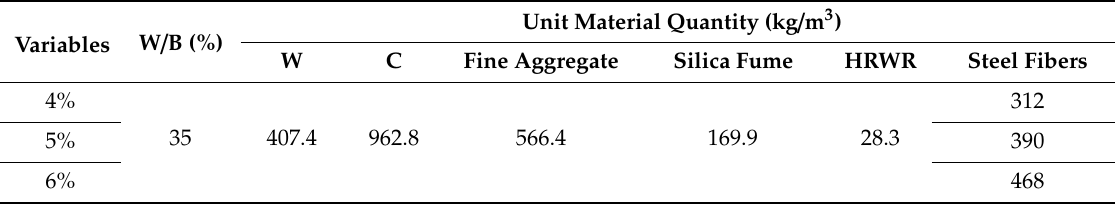
Table 3. Slurry-Infiltrated Fiber-Reinforced Cementitious Composites( SIFRCCs) mixing formula.